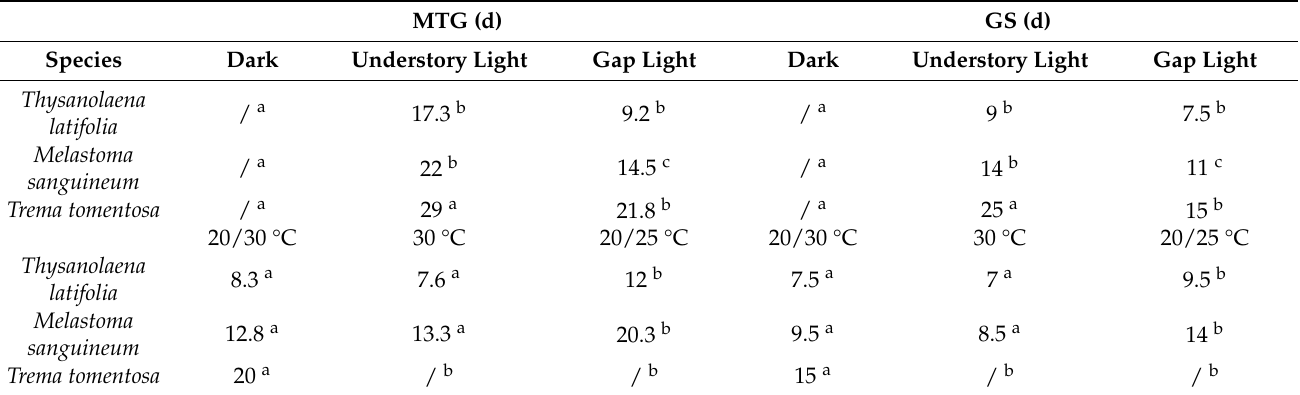
Table 4. The mean time to germinate (MTG) and germination starting time (GS) of the three represen- tative species under different photo-thermal conditions of the indoor verification experiment.